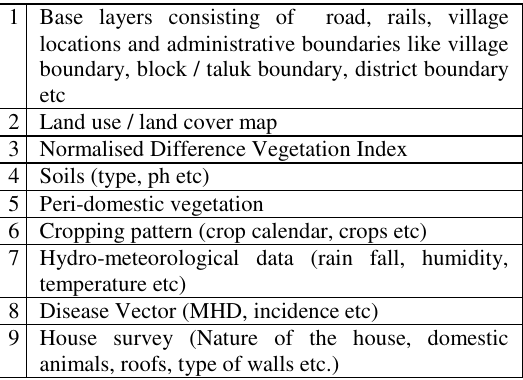
Table 3 – List of variables used for the